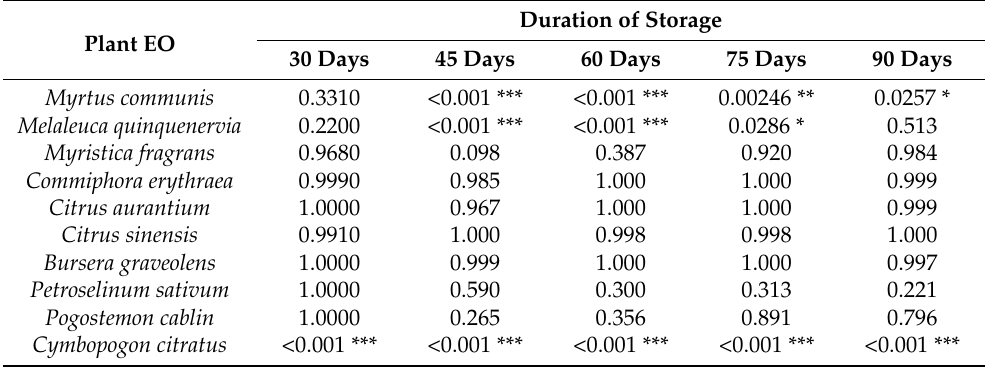
Table 2. Tukey’s test p -values describing the EOs’ effects on sprout length relative to the control at all time points (*, **, *** = statistically significant).